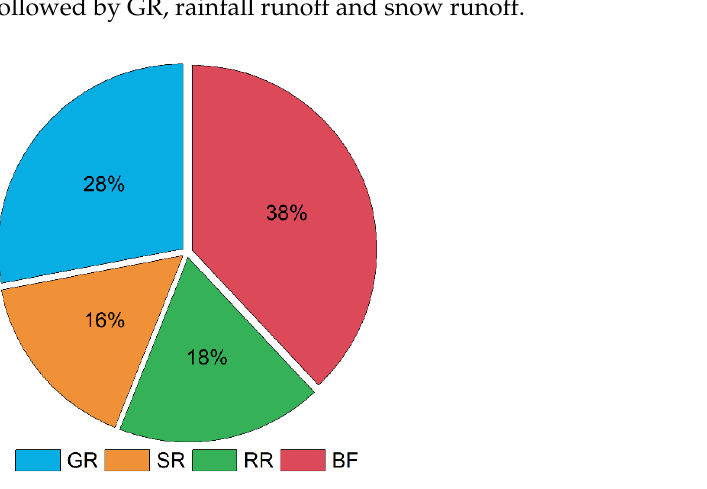
Figure 13. Comparison of contributions of runoff components to total runoff before and after the abrupt change of the total runoff. 4.2. Increasing Total Runoff Dominated by Increasing Rainfall Figure 14 shows the interannual variation of the contributions of the four runoff com- ponents to the total runoff and the five-year fast Fourier filter of the contributions. As can be seen from the figure, the contribution of GR to the total runoff showed a trend of first increasing and then decreasing. Although the interannual variation of snow runoff did not show a significant decreasing trend, the contribution of snow runoff to the total runoff did. The decreasing trend of the contribution of GR and snow runoff to the total runoff indicates that the alimentation of the glaciers and snow cover to the river runoff was de- creasing. The five-year fast Fourier filter of the contribution of rainfall runoff indicates that the contribution of rainfall runoff to the total runoff showed a significant increasing trend, consistent with the increasing trend of rainfall runoff. Although it can be seen from Figure 10d that the baseflow had a significant increasing trend, the contribution of the baseflow to the total runoff showed a significant decreasing trend, meaning the trends of the baseflow and contribution of the baseflow were the opposite. Moreover, according to the structure of the SPHY model, the water source of the baseflow is mainly the percola- tion of rainfall and a small part made up by glacier meltwater, meaning an increase of the baseflow actually depends on an increase of rainfall. The decreasing trends of the contri- butions of GR, snow runoff and the baseflow to the total runoff, and the increasing trend of rainfall runoff in contributing to the total runoff fully indicate that with climate change and global warming, the rapid melting of glaciers in the past decades was an important